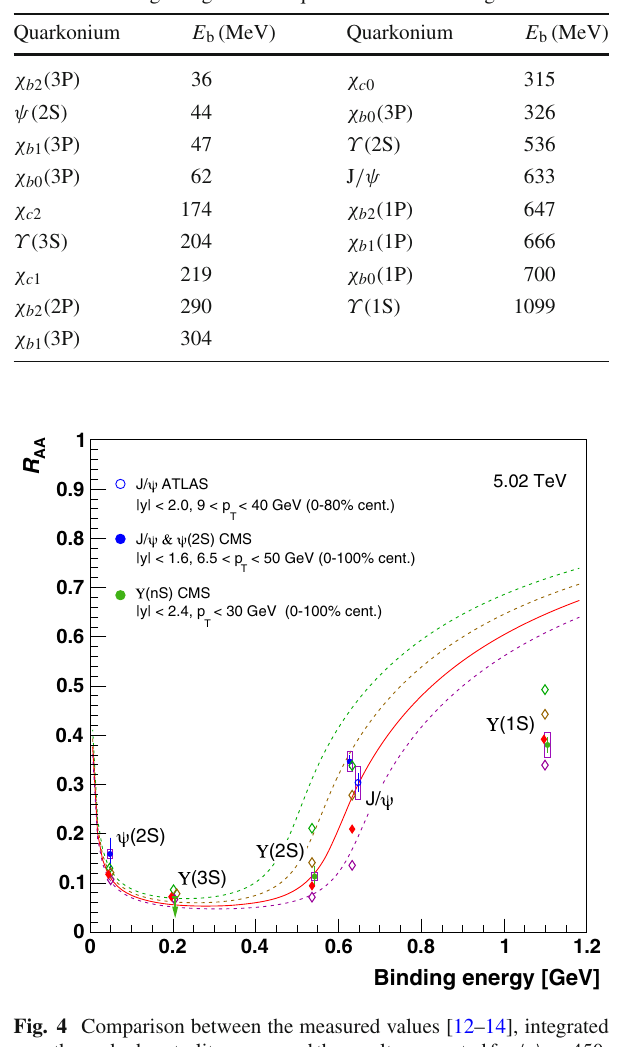
Figure6showsthatthefitted (cid:4) (cid:8) (cid:5) parametergrowslogarith- mically with N part , reaching 566 ± 15MeV for N part = 400. The fitted value of σ (cid:8) is 30 ±